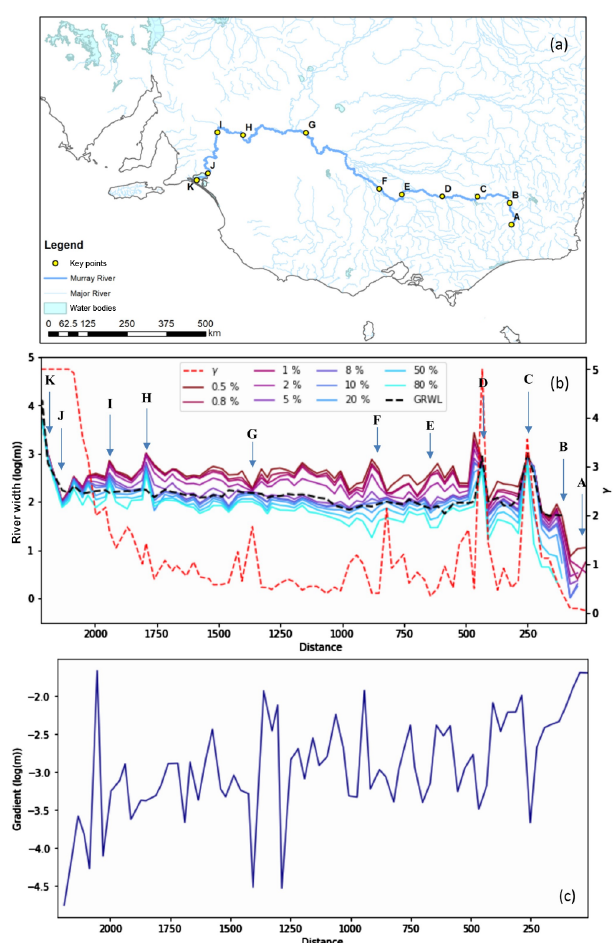
Figure 11. Longitudinal profile of the Murray River showing (a) lo- cation of river and selected locations; (b) profile of width at dif- ferent frequencies and river morphology parameter γ ; and (c) pro- file of river gradient. Values are averaged for 30km sections along the river channel. Letters indicate (A) source according to our data; (B) source according to GRWL data (Allen and Pavelsky, 2018); (C) Lake Hume; (D) Yarrawonga Weir; (E–F) anabranching